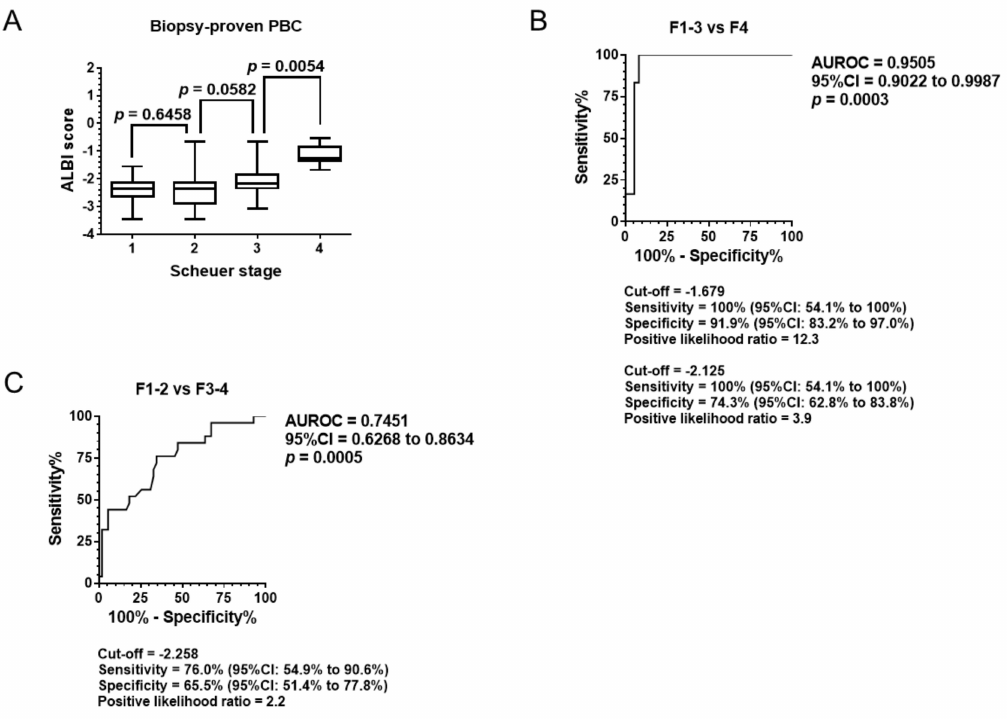
Figure 1. Diagnostic ability of pathological stage. ( A ) Relationship between Scheuer stage and the ALBI score in the biopsy-proven PBC cohort. ( B ) AUROC distinguishing cirrhosis from noncirrhotic status. ( C ) AUROC di ff erentiating advanced fibrosis from nonadvanced fibrosis. ALBI, albumin–bilirubin; PBC, primarybiliarycholangitis; AUROC,areaunderreceiveroperatingcharacteristic;